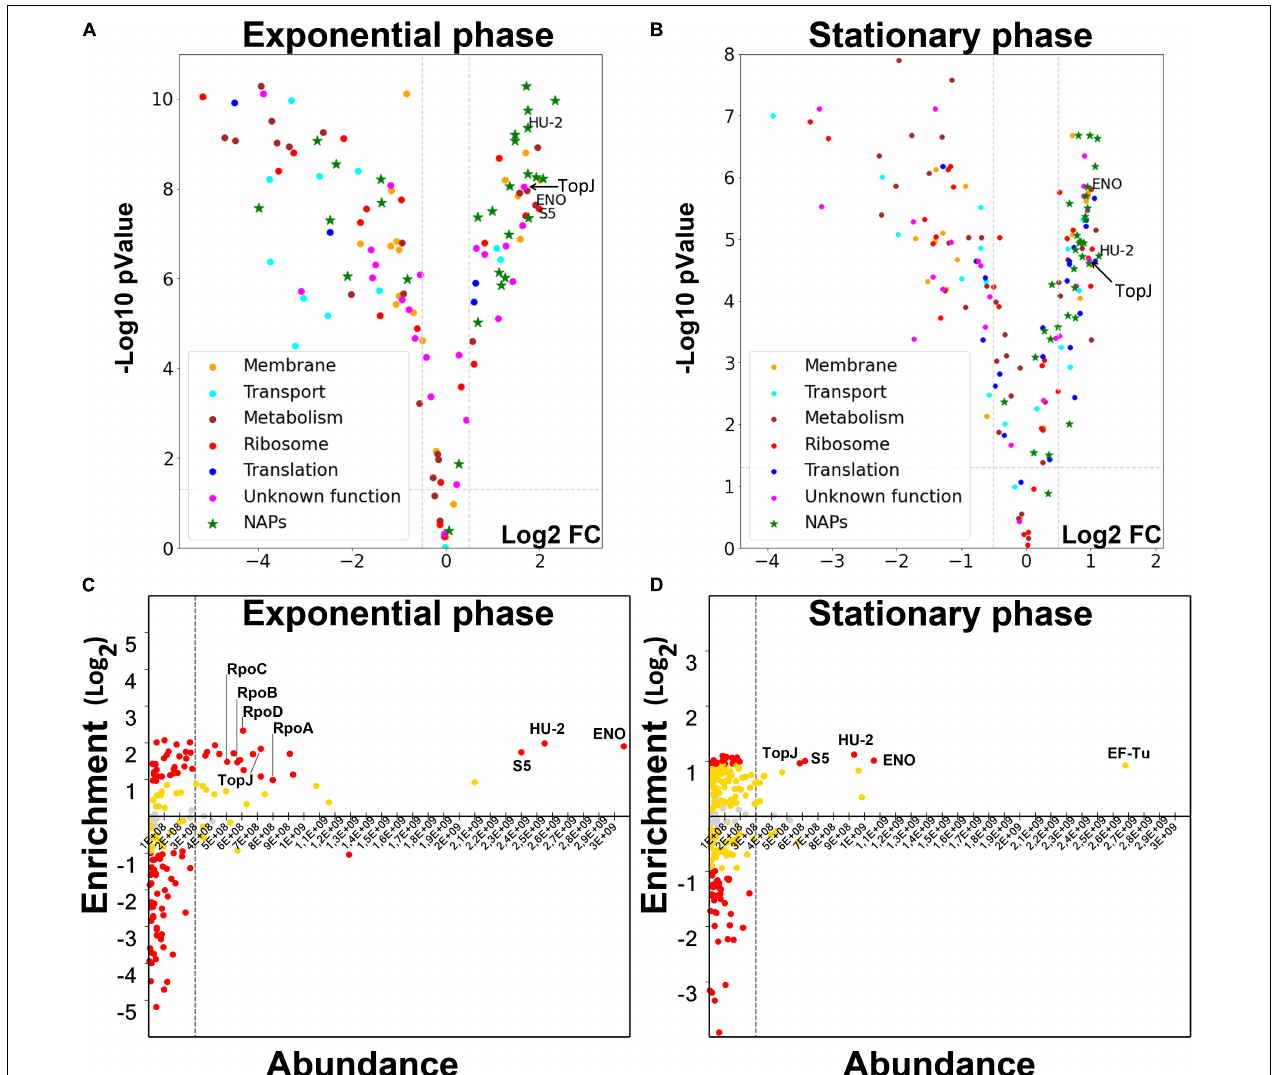
FIGURE 4 | (A,B) Volcano plots of the protein enrichment data for M. gallisepticum nucleoid in the exponential (A) and the stationary (B) growth phases. Putative NAPs were predicted based on homology with known proteins. Cutoffs (log 2 fold change ± 0.5 and p-value = 0.05) are shown as dashed lines. (C,D) The distribution of the identified NAPs of the M. gallisepticum according to their enrichment in the nucleoid fraction compared to lysate and the abundance within the nucleoid fraction in the exponential (C) and the stationary (D) growth phases. Vertical axis represents Log 2 fold change of the protein abundance in the nucleoid fraction compared to the total lysate (the positive values indicate enrichment in the nucleoid fraction, the negative ones indicate depletion). Red dots represent proteins with the statistically significant (p-val < 0.05) enrichment or depletion more than two-fold. Yellow dots represent protein with enrichment or depletion less than two-fold, but still statistically significant (p-val < 0.05). Gray dots represent proteins, which enrichment or depletion is not statistically